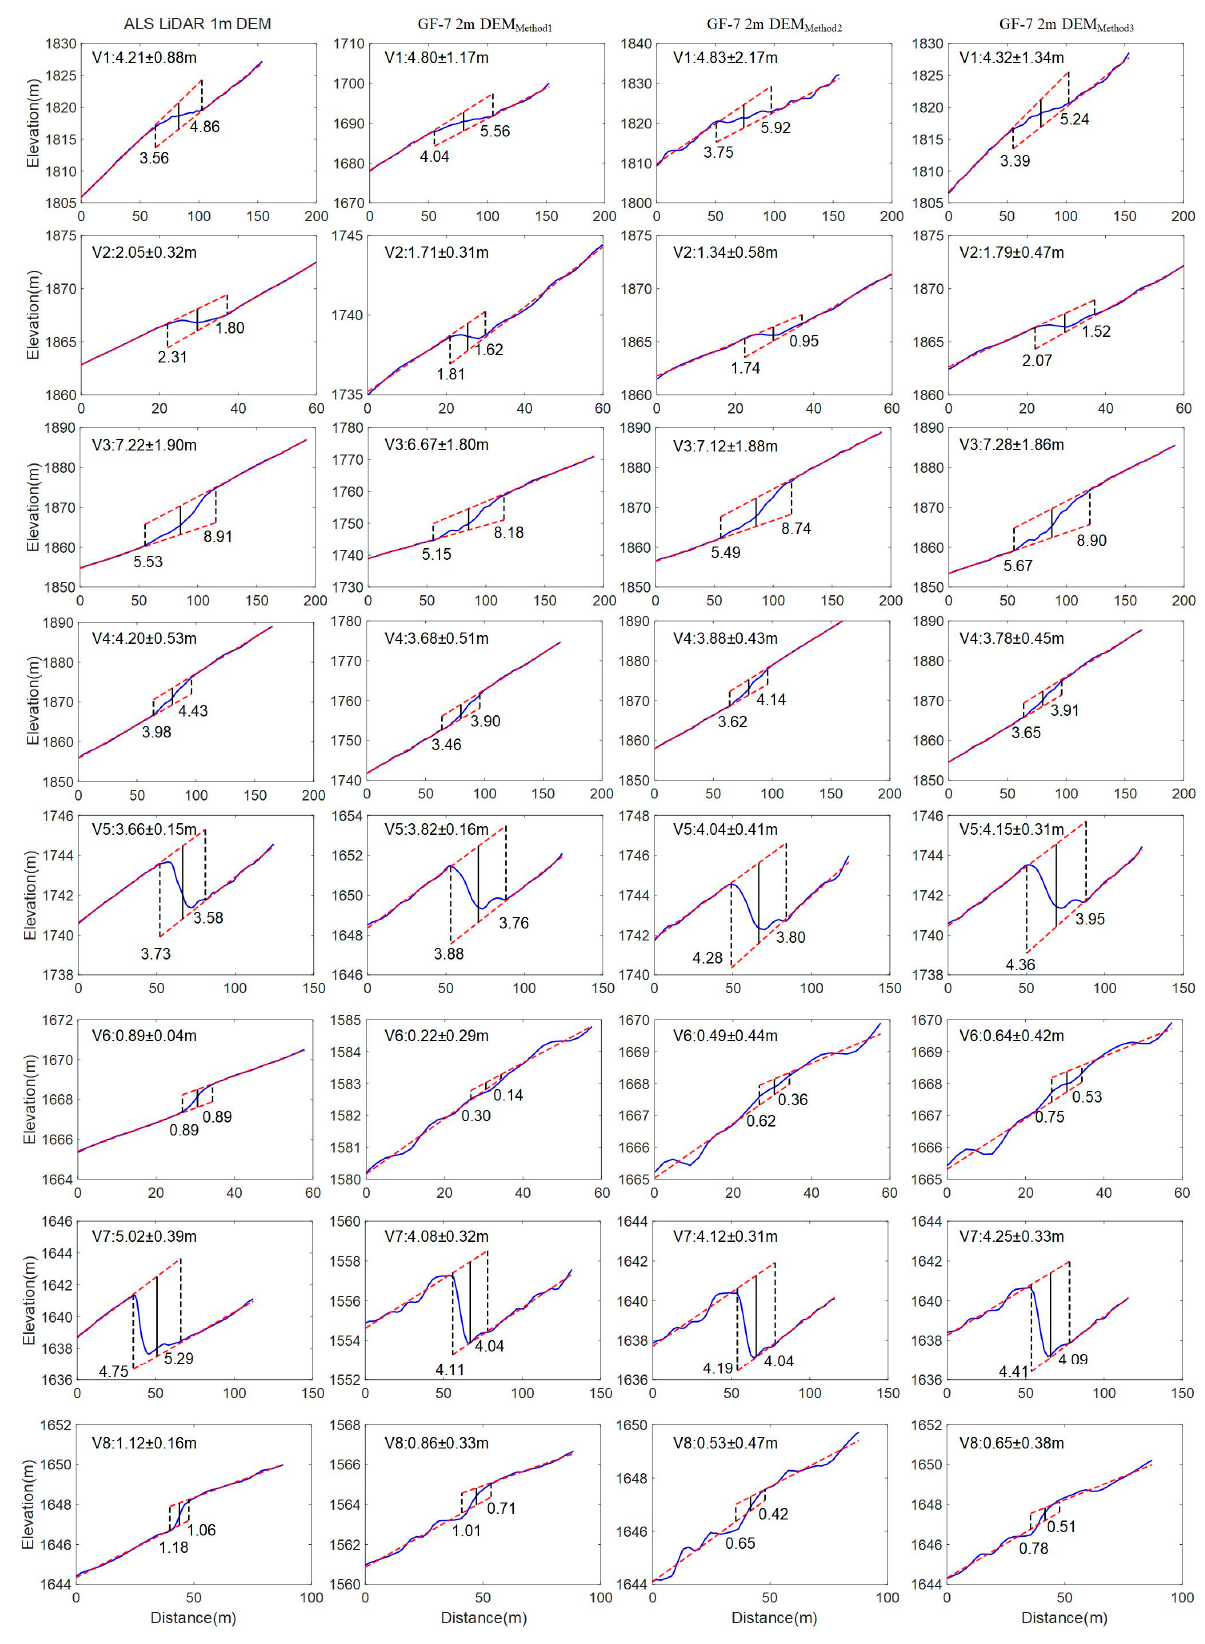
Figure 12. Vertical offsets of V1–V8 measured by the airborne LiDAR-derived DEM, GF-7 DEM Method1 , GF-7 DEM Method2 , and GF-7 DEM Method3 .